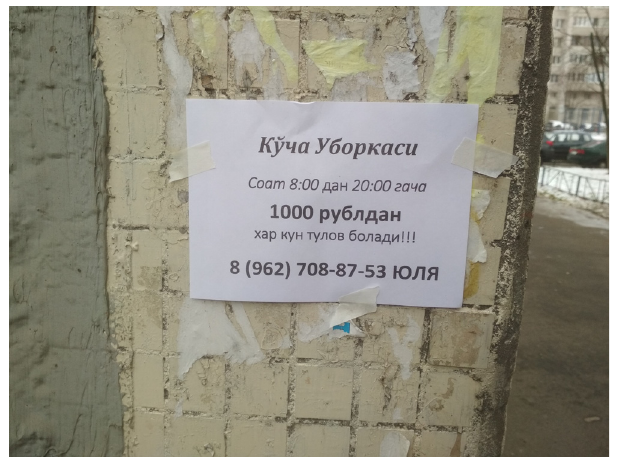
Figure 6: Call for a street cleaning job in Uzbek, Pr. Prosveshcheniya, St. Petersburg, 2019, LinguaSnapp SPb.